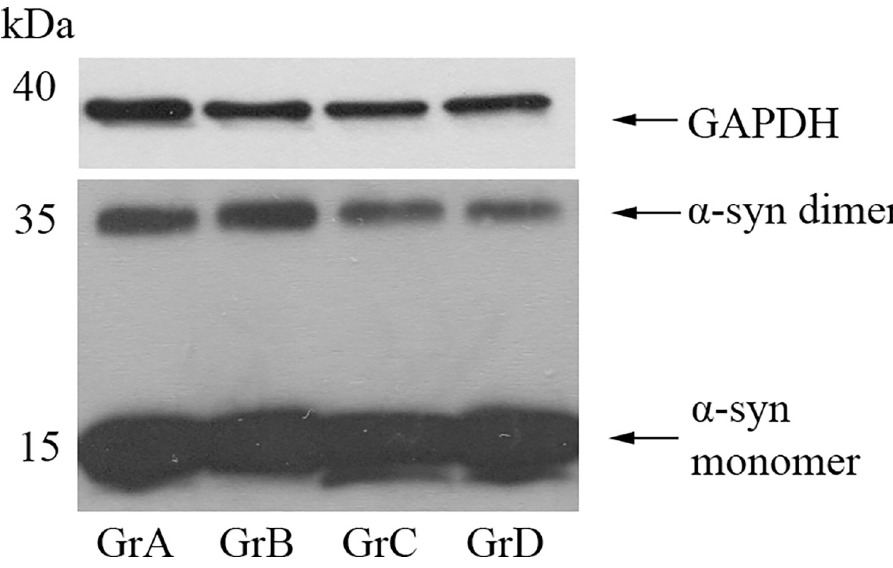
Fig 1. Representative immunoblots of α -synuclein monomer and dimer for the four different study groups. GrA, Gaucher disease patients receiving no treatment; GrB, Gaucher disease patients after treatment; GrC, Gaucher disease carriers; GrD, controls. Quantification was made relative to the levels of the loading control (GAPDH, glyceraldehyde 3-phosphate